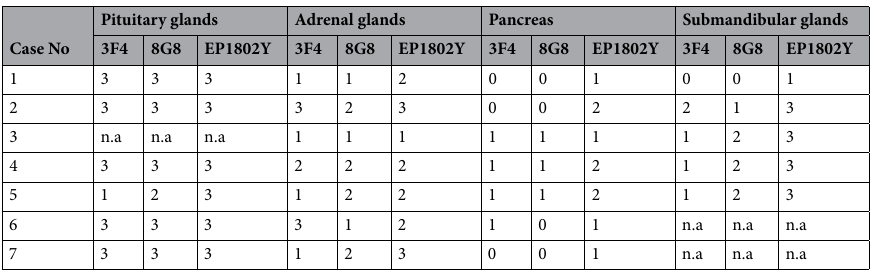
Table 3. Immunopositivity after prion protein immunostaining. Scale: 0, negative; 1, mild; 2, moderate; 3, strong; n.a., not available. 3F4, 8G8, and EP1802Y: prion protein